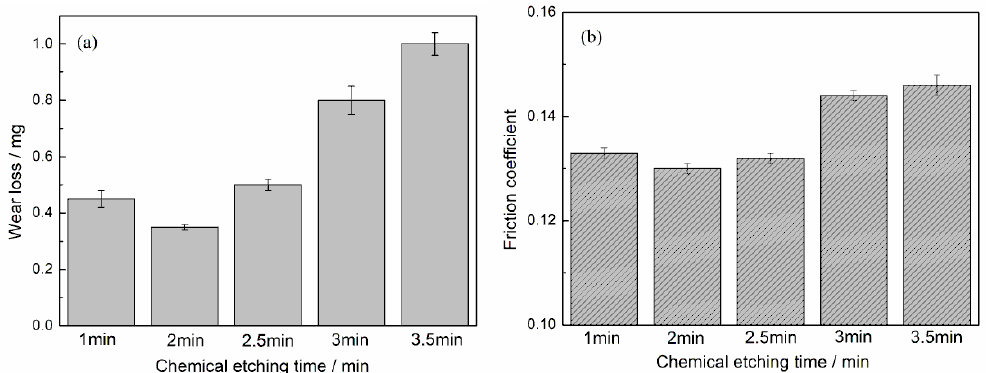
Figure 11. Effect of chemical etching time on the ( a ) wear loss and ( b ) friction coefficient.